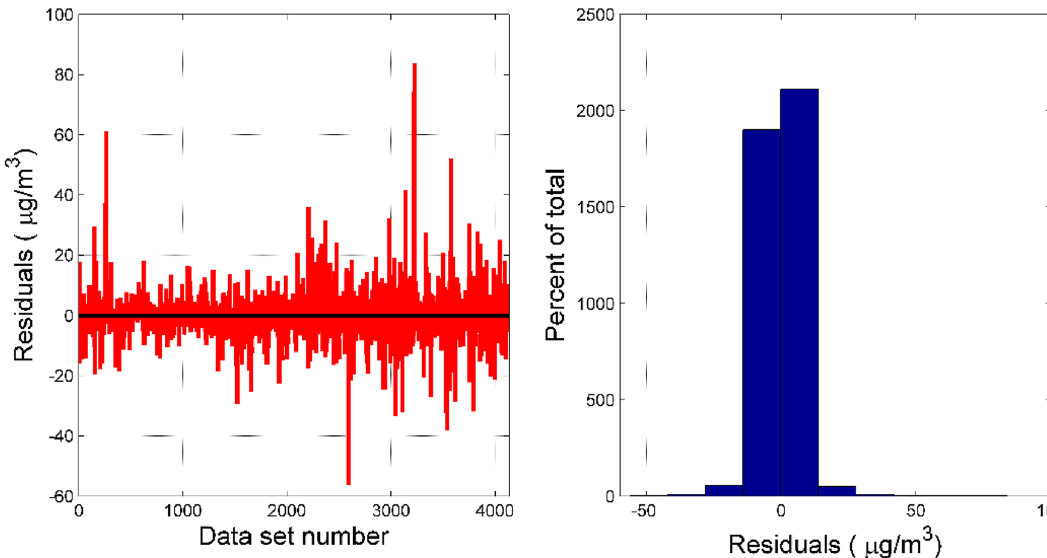
Figure 8. Residual test of RR-XGBoost model. The residuals vs. data set number plot is seen on the left. The histogram of the residuals is seen on the